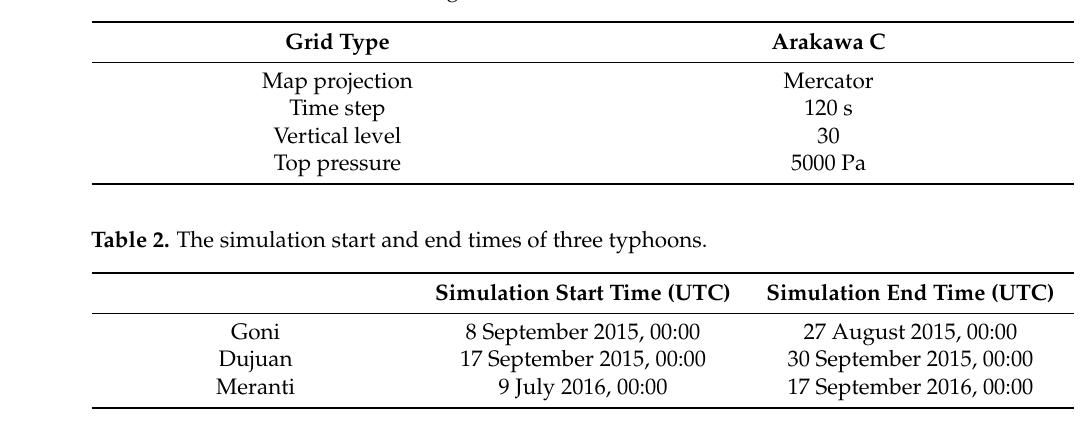
Figure 1. The Weather Research and Forecasting (WRF) simulated domain (whole figure) and the Simulating WAves Nearshore (SWAN) simulated region (orange square). The tracks of typhoon Goni (purple line), Dujuan (red line), and Meranti (blue line). Red triangles are the locations of buoys in the Taiwan Strait. Table 1. The characteristics of WRF grids.